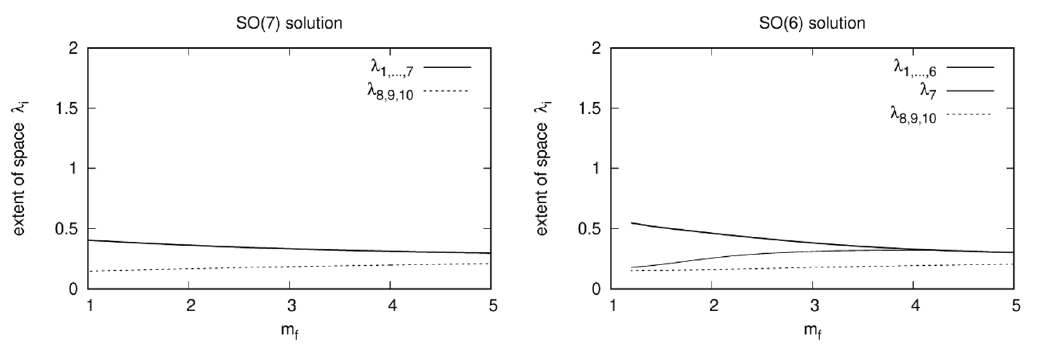
Figure 4 . The extent of space in each direction is plotted against m f for the SO(7) ansatz (Left) and for the SO(6) ansatz (Right). For the SO(7) ansatz, we plot (cid:21) 1 = : : : = (cid:21) 7 and (cid:21) 8 = (cid:21) 9 = (cid:21) 10 . For the SO(6) ansatz, we plot (cid:21) 1 = : : : = (cid:21) 6 , (cid:21) 7 and (cid:21) 8 = (cid:21) 9 = (cid:21) 10